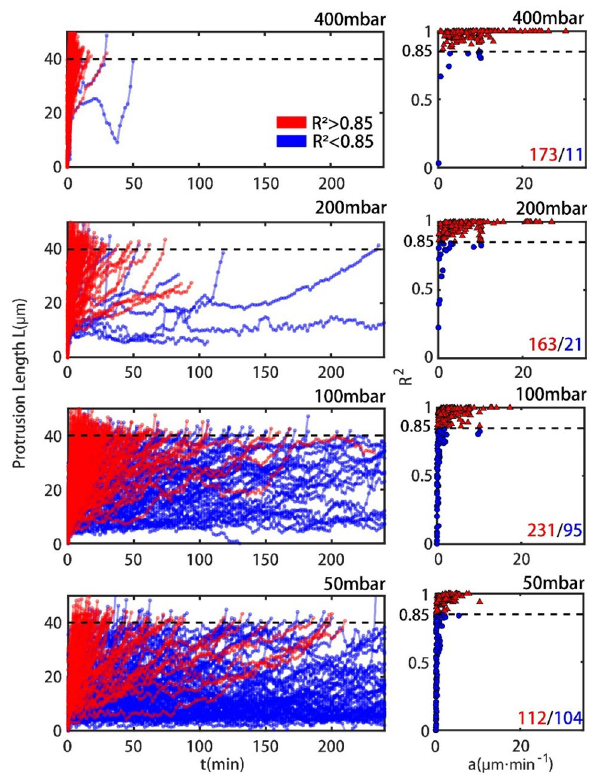
Figure 2. Left: Dynamic behaviors of cancer cells traversing microvessels with 7.5 μm × 6 μm × 40 μm over time under four applied pressure differences (cid:31) P (400 mbar, 200 mbar, 100 mbar and 50 mbar); Right: Scatter plot of R-square and fitting velocities for cells traversing microvessels with 7.5 μm × 6 μm × 40 μm under four applied pressure differences (cid:31) P (400 mbar, 200 mbar, 100 mbar and 50 mbar). Red lines and Blue lines indicated cells with R-squared of linear fitting larger or smaller than